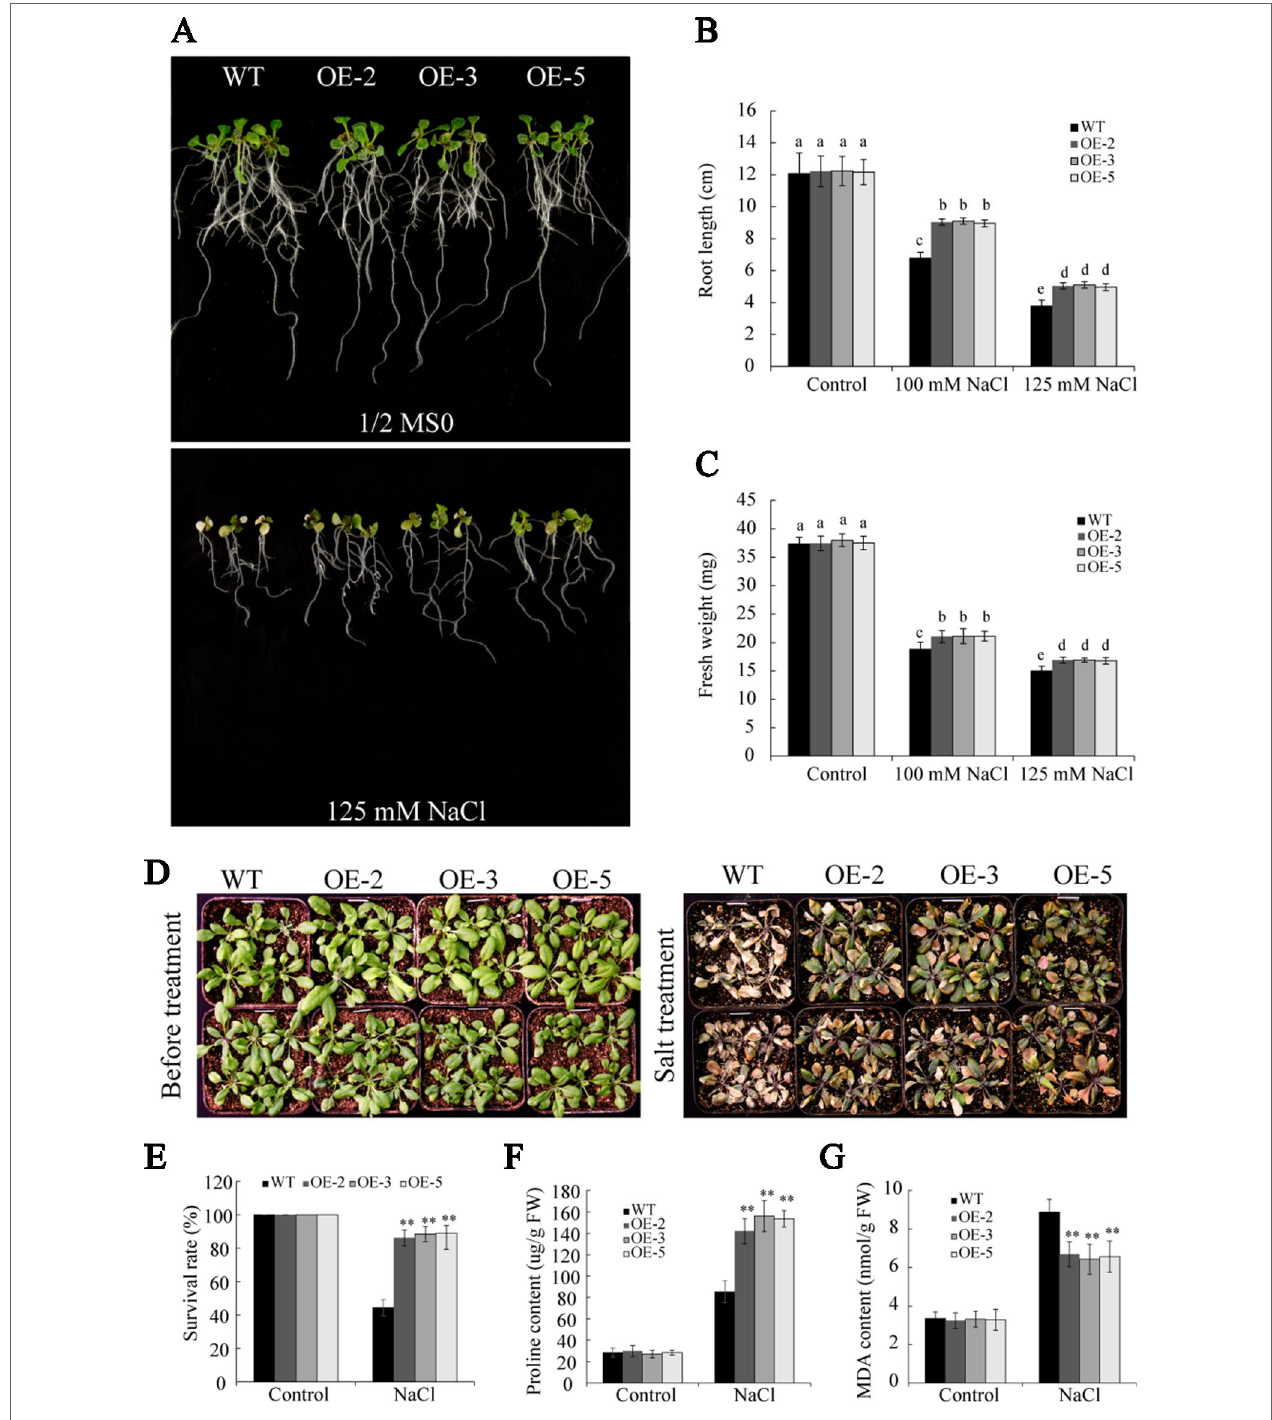
FiGURe 11 | Overexpression of GmSAP16 improves salt tolerance in Arabidopsis . (A) Root length assays of wild-type (WT) and GmSAP16 transgenic Arabidopsis under salt treatment. Five-day-old seedlings of WT and GmSAP16 -overexpressing lines were transferred to 1/2 Murashige and Skoog (MS) medium containing the indicated concentrations of NaCl (0, 100, and 125 mM). Measurements of main root length (B) and fresh weight (c) for at least 20 seedlings. (D) Salt tolerance phenotypes of WT and GmSAP16 transgenic lines in soil. Three-week-old seedlings of WT and GmSAP16 transgenic Arabidopsis were treated with 250 mM NaCl for 1 week. Statistical analysis of the survival rates (e) , proline content (F) , and MDA content (G) . Error bars indicate the SD of three independent replicates. Asterisks represent significant differences between WT and GmSAP16 -overexpressing lines (**, P 0.01; Student’s t test). Different letters indicate significant differences within treatments by ANOVA (P